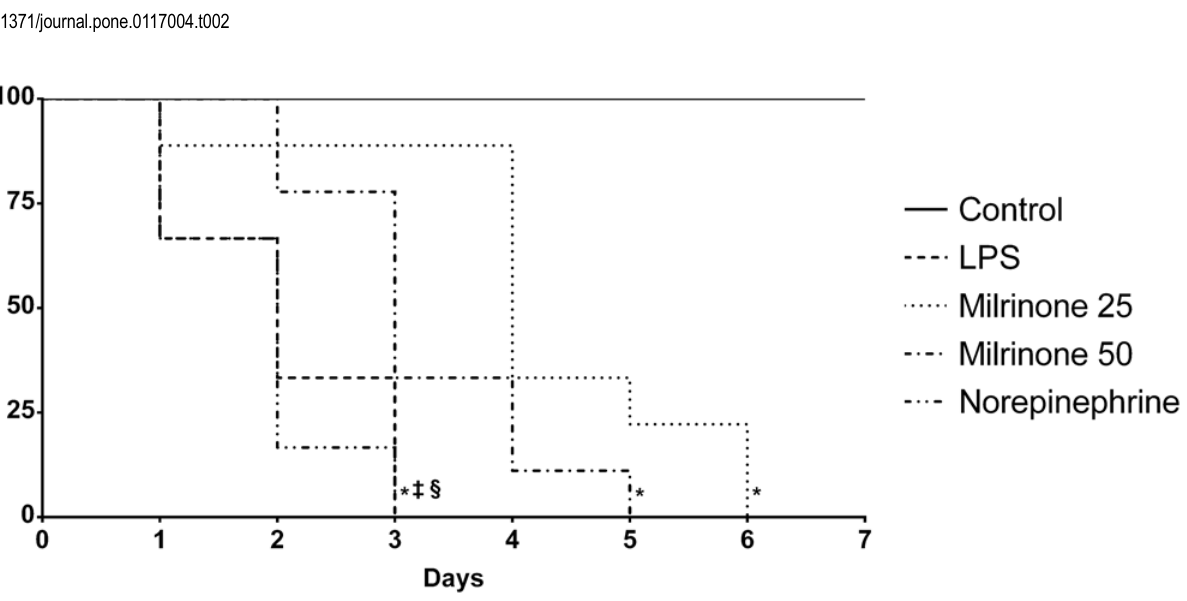
Fig 7. Kaplan-Meier survival curves. Control, non-endotoxemic animals (n = 10); LPS, endotoxemic animals (n = 10); Milrinone 25, endotoxemic and milrinone 0.25 μ g.kg -1 .min -1 treated animals (n = 10); Milrinone 50, endotoxemic and milrinone 0.50 μ g.kg -1 .min -1 treated animals (n = 10); Norepinephrine, endotoxemic and norepinephrine treated animals (n = 10). * p < 0.05 vs . Control group; ‡ p < 0.05 vs . Milrinone 25 group; § p < 0.05 vs . Milrinone 50